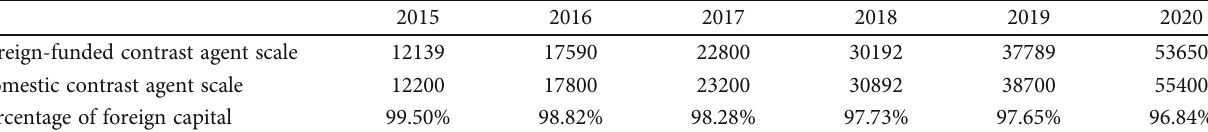
Table 1: Comparison between foreign-funded contrast agents and domestically produced contrast agents in recent years.